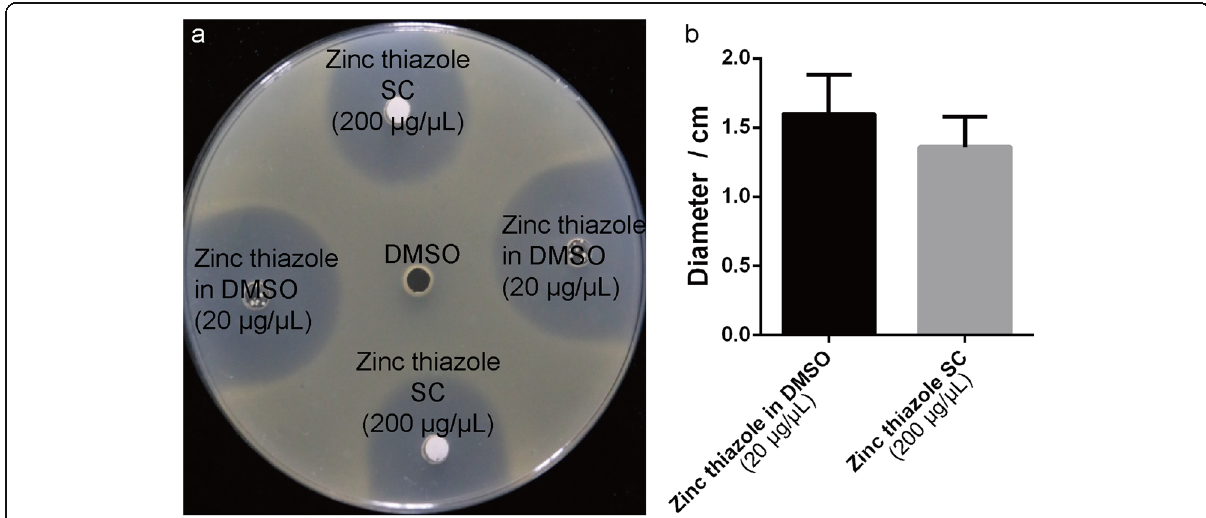
Fig. 2 Antibacterial activity of zinc thiazole against Xoo . a Antibacterial effect of zinc thiazole suspension concentrate (SC, 200 μ g/ μ L) and DMSO- solved zinc thiazole (20 μ g/ μ L) in Petri dishes containing Xoo . DMSO solvent (without dilution) added in the middle hole was used as a control. b Diameter of the inhibition zone produced by zinc thiazole SC and DMSO-solved zinc thiazole against Xoo. Error bars represent standard errors from three independent